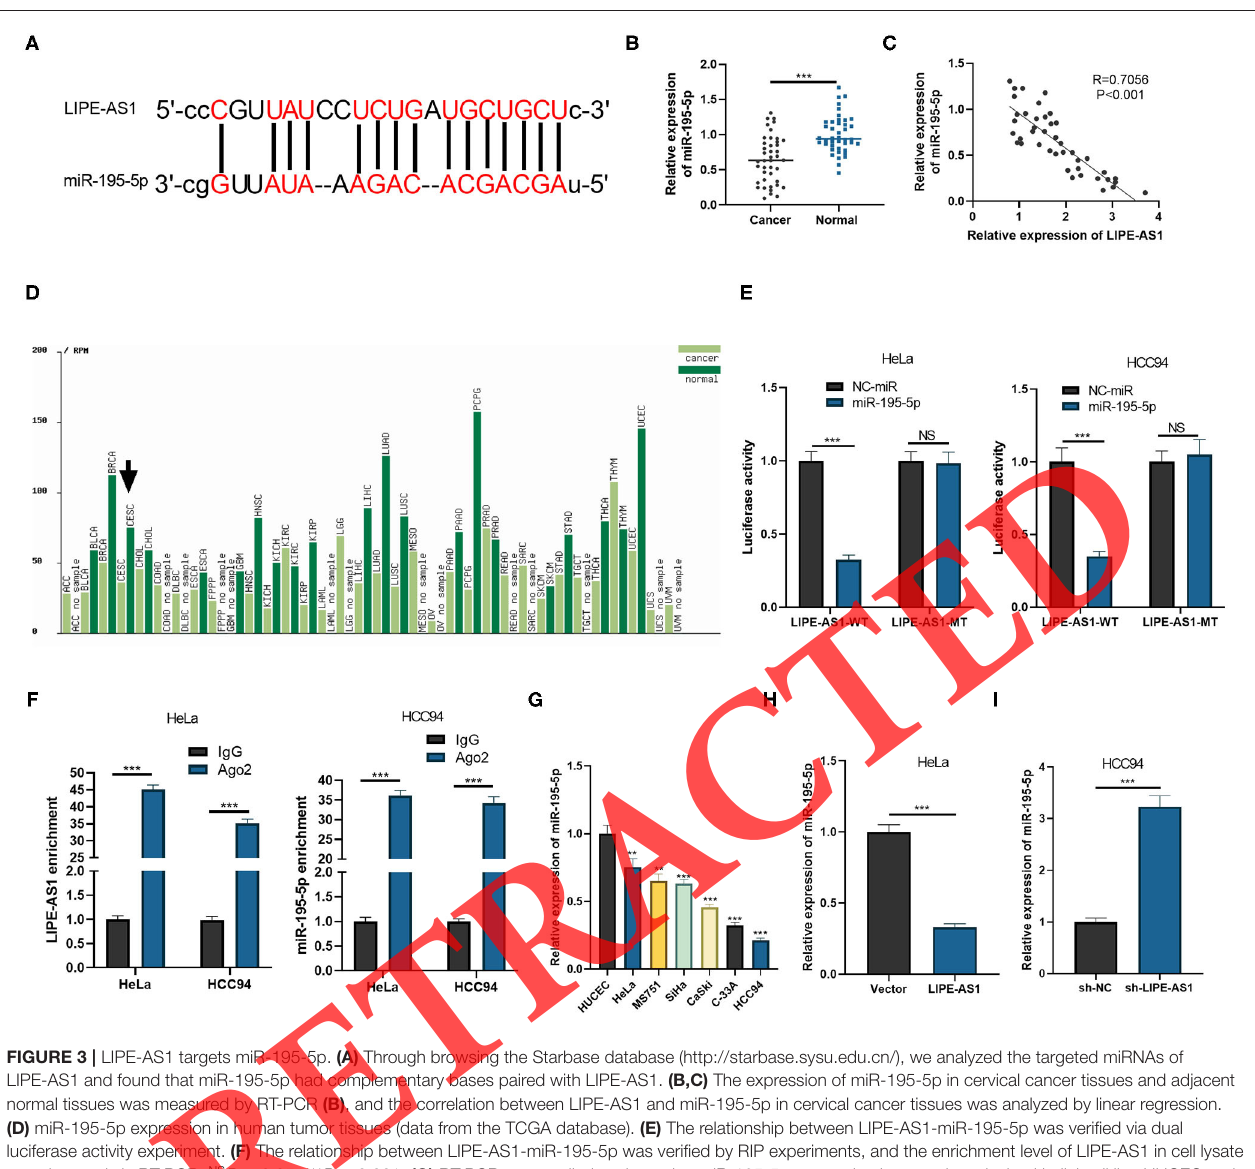
FIGURE 3 | LIPE-AS1 targets miR-195-5p. (A) Through browsing the Starbase database (http://starbase.sysu.edu.cn/), we analyzed the targeted miRNAs of LIPE-AS1 and found that miR-195-5p had complementary bases paired with LIPE-AS1. (B,C) The expression of miR-195-5p in cervical cancer tissues and adjacent normal tissues was measured by RT-PCR (B) , and the correlation between LIPE-AS1 and miR-195-5p in cervical cancer tissues was analyzed by linear regression. (D) miR-195-5p expression in human tumor tissues (data from the TCGA database). (E) The relationship between LIPE-AS1-miR-195-5p was verified via dual luciferase activity experiment. (F) The relationship between LIPE-AS1-miR-195-5p was verified by RIP experiments, and the enrichment level of LIPE-AS1 in cell lysate was detected via RT-PCR. NS P > 0.05, *** P < 0.001. (G) RT-PCR was applied to determine miR-195-5p expression in normal cervical epithelial cell line HUCEC and cervical cancer cell lines (including Hela, MS751, SiHa, CaSki, C-33A, and HCC94). ** P < 0.01, *** P < 0.001 vs. HUCEC group. (H,I) RT-PCR detected changes in miR-195-5p after silencing or overexpressing LIPE-AS1. *** P < 0.001. N = 3. The arrow shows that miR-195-5p is down-regulated in CESC (Cervical squamous cell carcinoma and endocervical adenocarcinoma) tissues compared with that in the normal